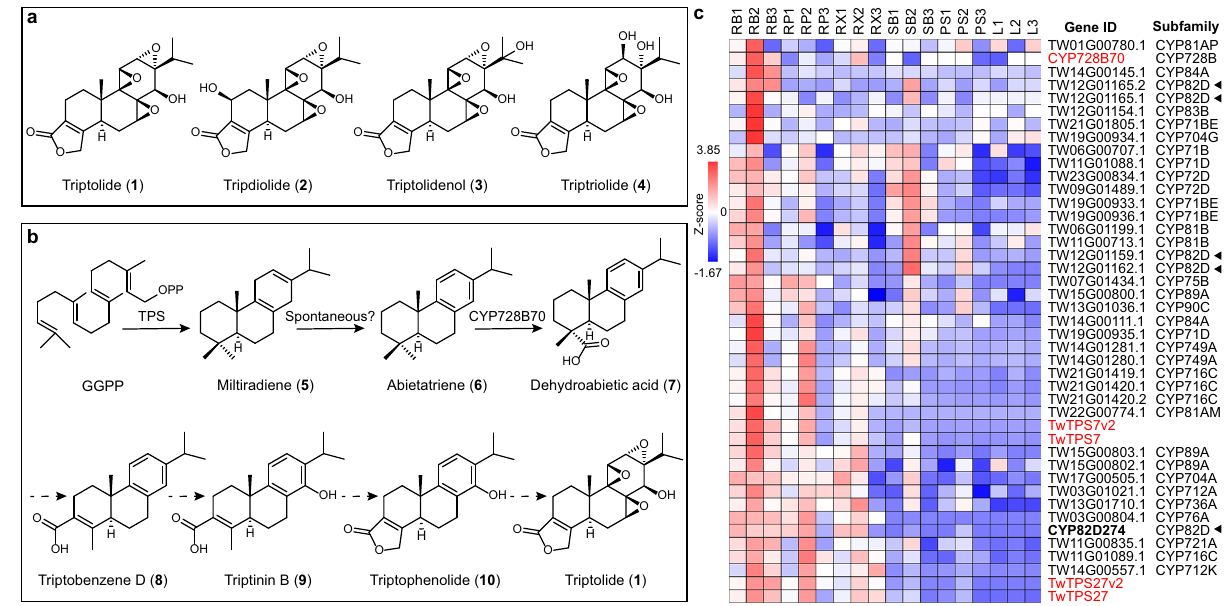
Fig. 1 | Bioactive metabolites in Tripterygium wilfordii and biosynthesis of triptolide.a Structuresofmajorbioactivediterpenoidsof T.wilfordii . b Proposed triptolide biosynthetic pathway. A solid arrow represents an identi fi ed reaction, and a dotted arrow indicates an unknown pathway. GGPP: Geranylgeranyl dipho- sphate. c Coexpression pro fi les of CYPs with genes in the triptolide biosynthetic